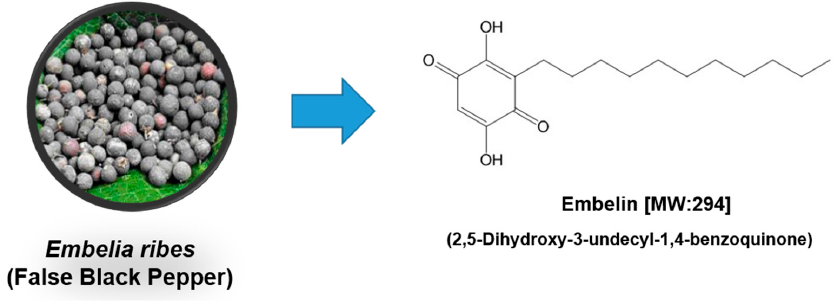
Figure 1. The chemical structure of embelin.